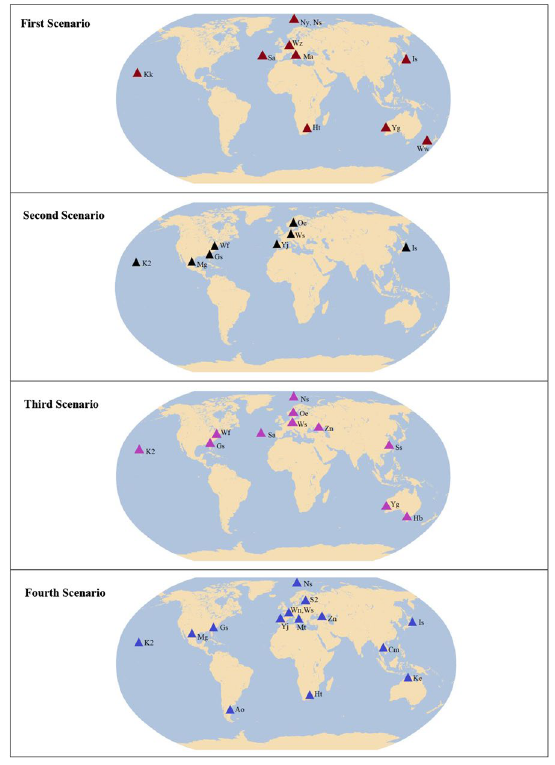
Fig. 3 Reference network of four scenarios showing reference stations marked in triangles with two-letter station name that is described in the methodology